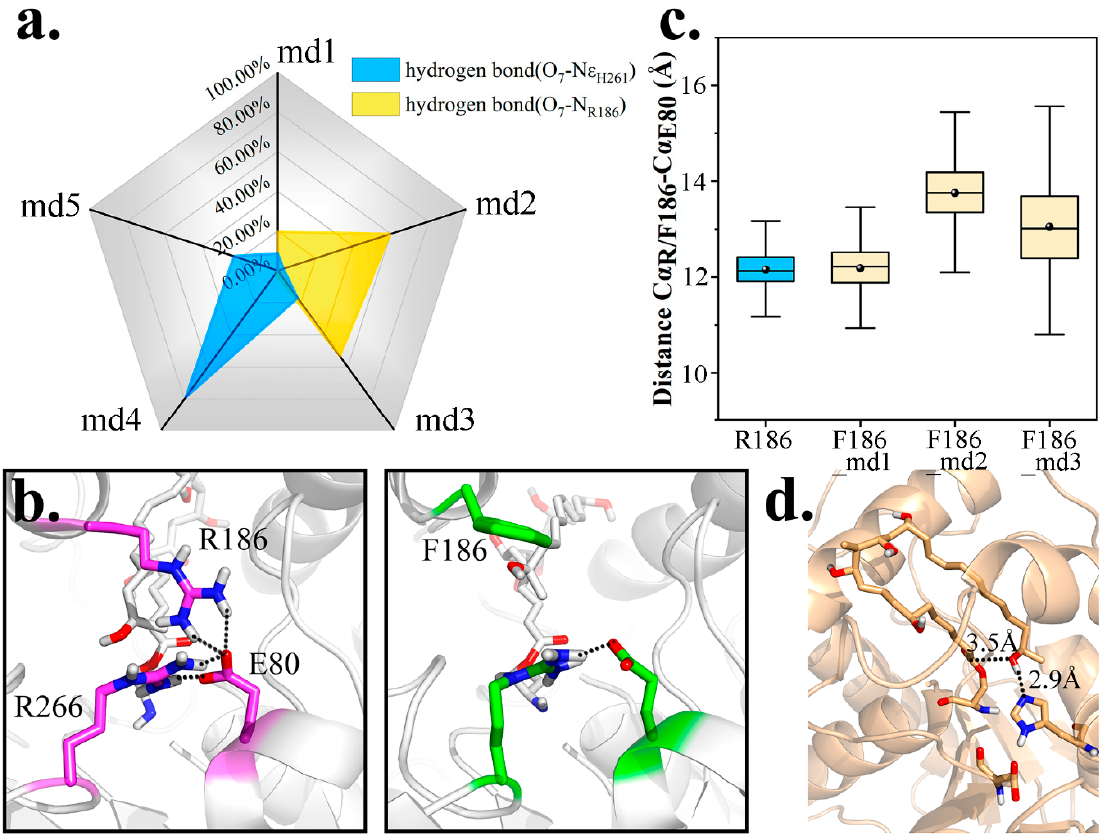
Figure 8. Mutational trials on R186. ( a ) Radar chart indicating the proportion of hydrogen bond O 7 - N ε H261 and O 7 -N R186 formation within 5 wild type simulations. ( b ) Larger entrance of pima-TE after R186F mutation. ( c ) Coupling and non-coupling states of three entrance residues (R/F186, E80 and R266) located on different structure elements. ( d ) A favorable PRS emerged in R186Y